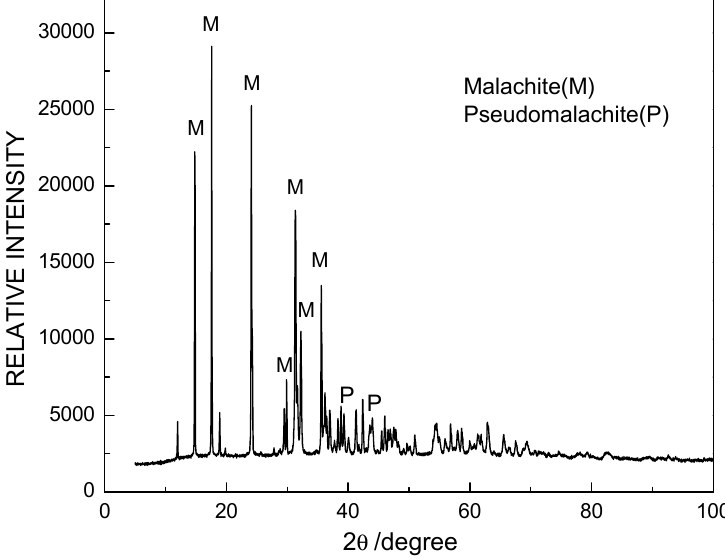
Figure 1. XRD pattern of the malachite sample.